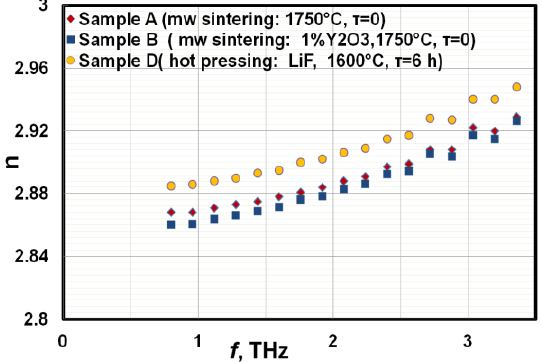
Fig. 1. The frequency dependencies of the refractive index of MgAl 2 O 4